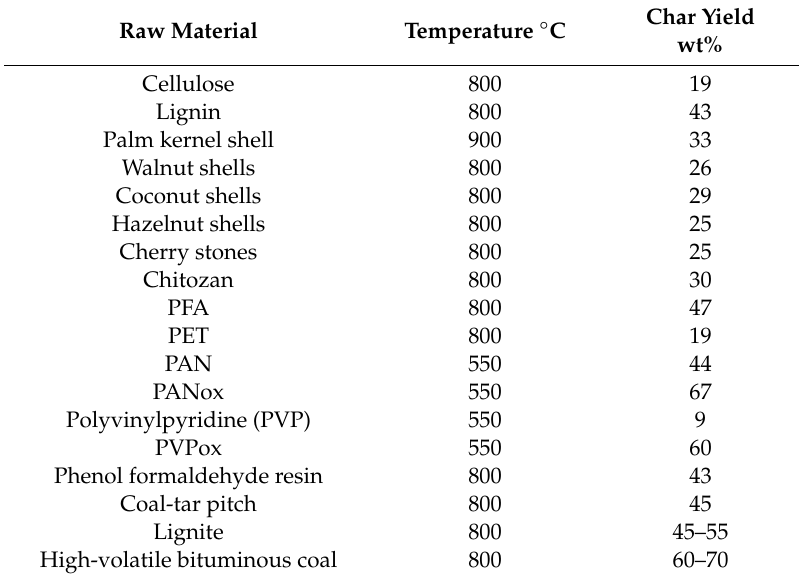
Table 2. Char yields obtained on carbonization of various lignocellulosic, polymeric and carbonaceous raw